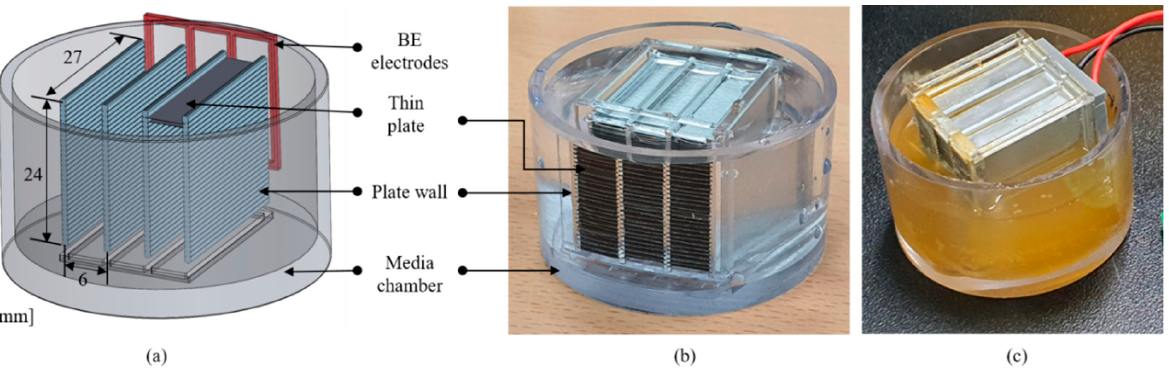
Figure 2. ( a ) Schematic of the total biomass test: structural components mimicked an automotive evaporator core. ( b ) Photo of the testing setup. ( c ) Photo of the total biomass test after 48 h of biofilm growth.